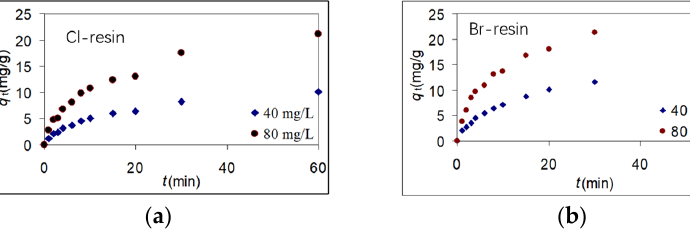
Figure 2. Mass  time pro fi les of Cd 2+ adsorption on X −  loaded resins. ( a ) Cl  resin, ( b ) Br  resin, ( c ) Figure 2. Mass-time profiles of Cd 2+ adsorption on X − -loaded resins. ( a ) Cl-resin, ( b ) Br-resin, I  resin. ( c )